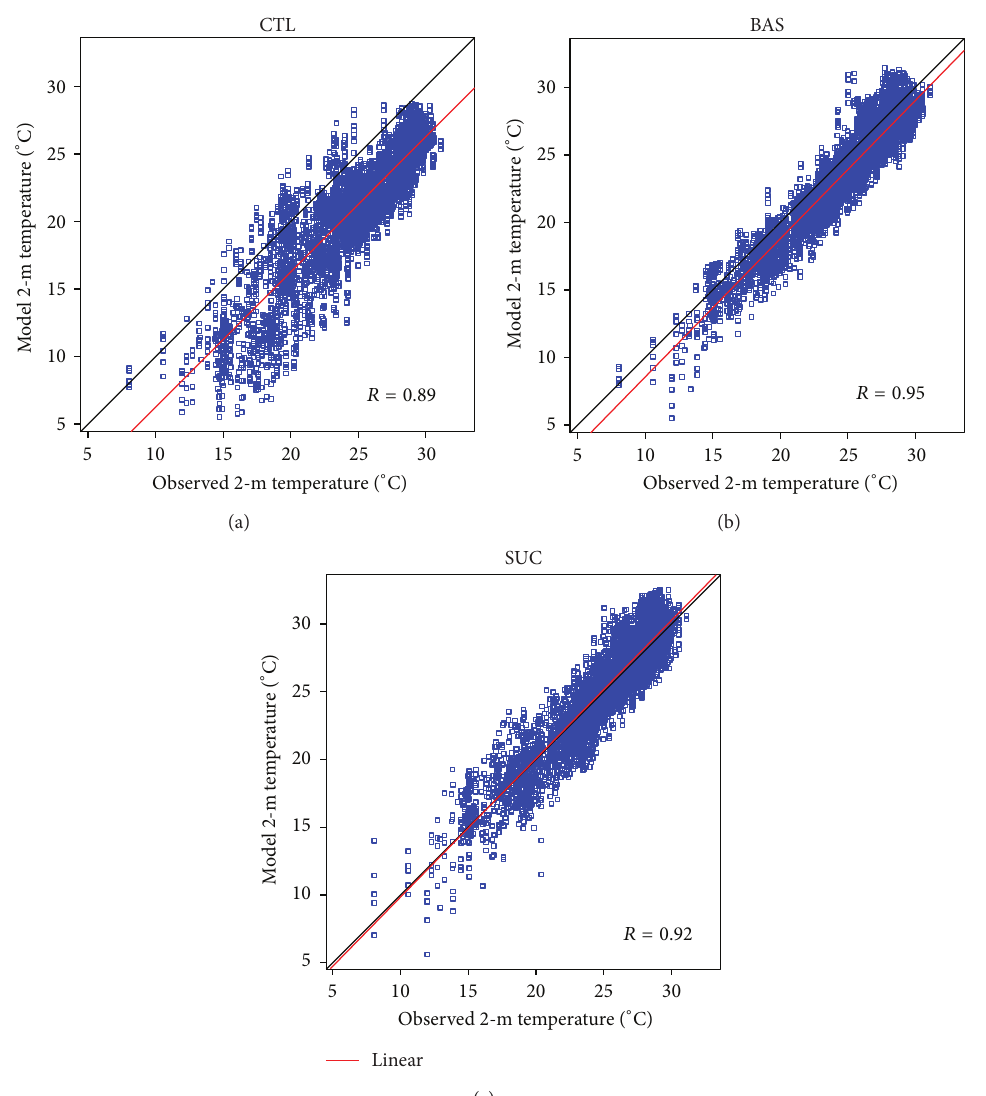
Figure 4: Relationship between observed and forecasted T2m ( ∘ C) by RegCM CFSv2 for all stations, all target months, and all lead times for experiments of (a) the control run —CTL, (b) the bias correction by model climatology —BAS, and (c) the successive adjustment of BAS with model bias at one month lead time of the previous run —SUC. The solid red line is the linear regression of the forecasted versus observed T2m. The perfect regression line is presented by the black